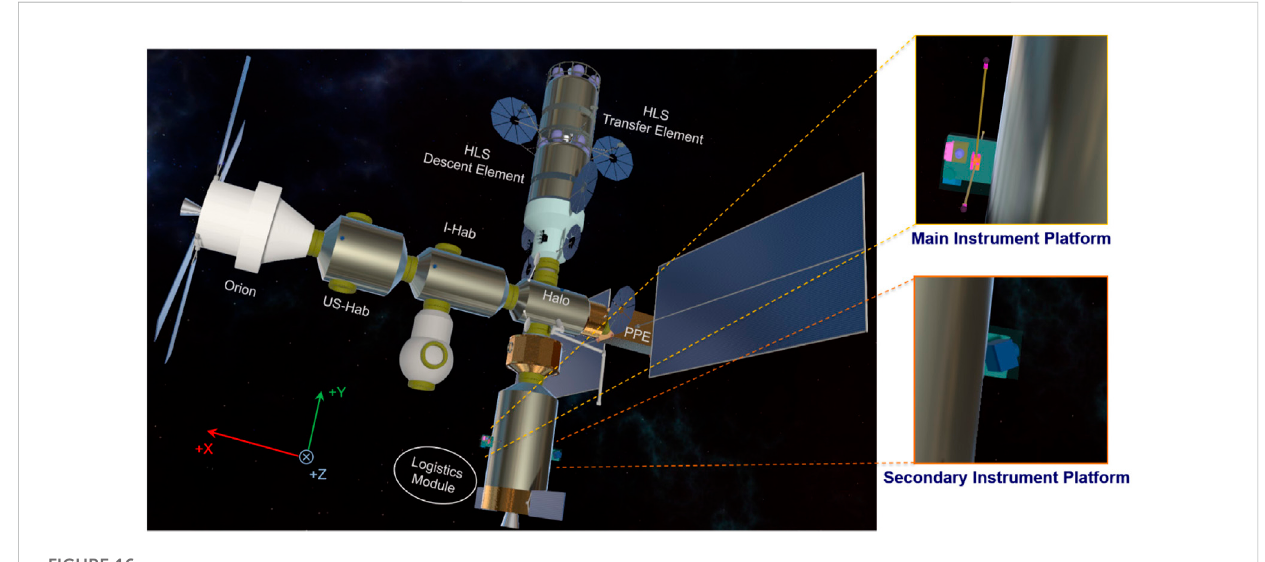
FIGURE 16 Main and Secondary Instrument Platforms, mounted on the +X side and on the – X side respectively of the Logistics